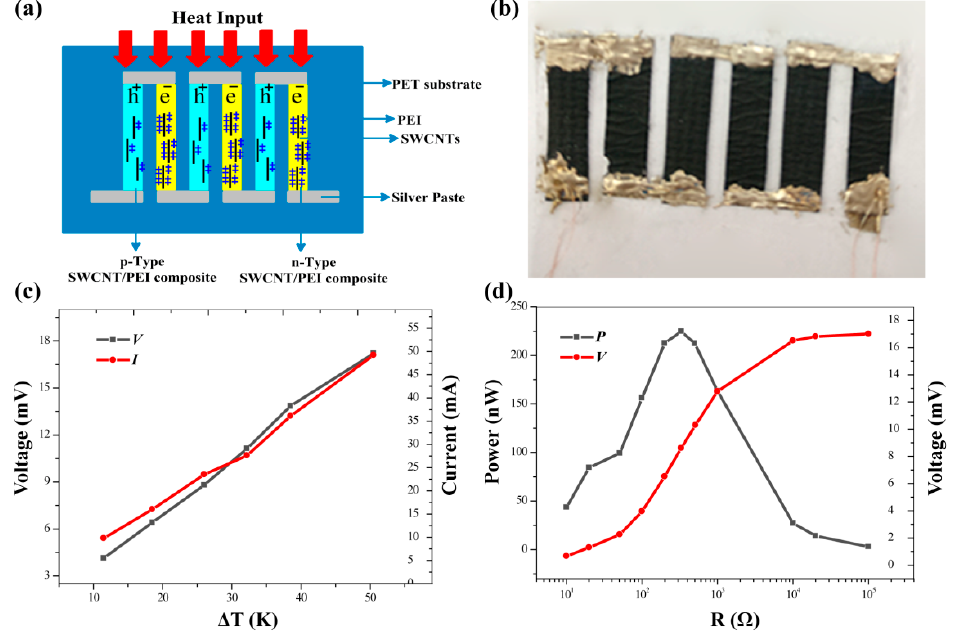
Figure 7. ( a ) Scheme and ( b ) demonstration of the TE generator comprised of three thermocouples. ( c ) Output voltage generated by a three p - n junction couples as a function of temperature gradient. ( d ) Output voltage and power as functions of different load resistances for the prepared device with